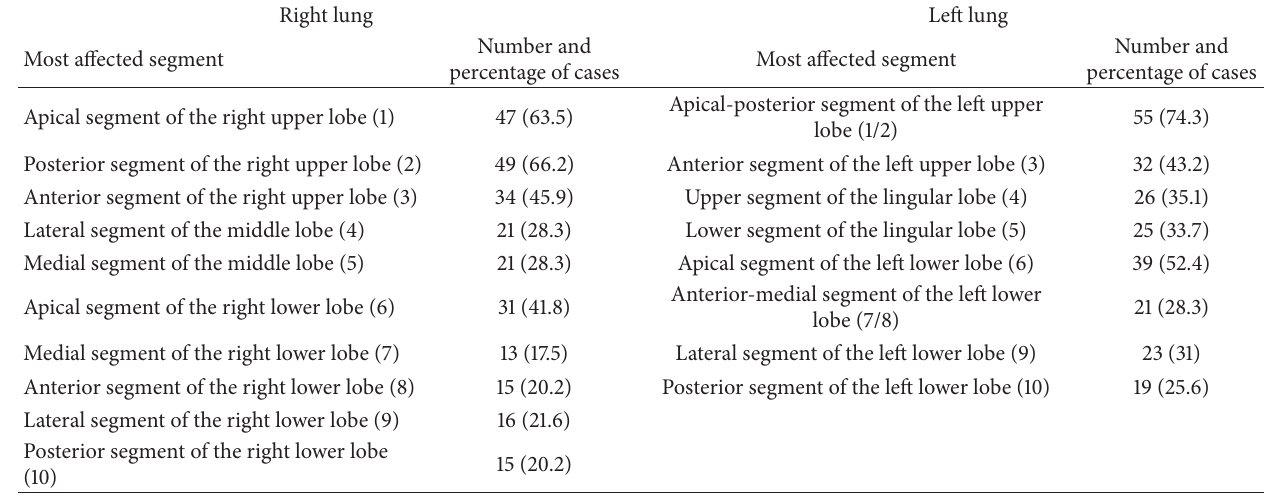
Table 1: Involvement of lobes and segments in 74 cases of active TB.